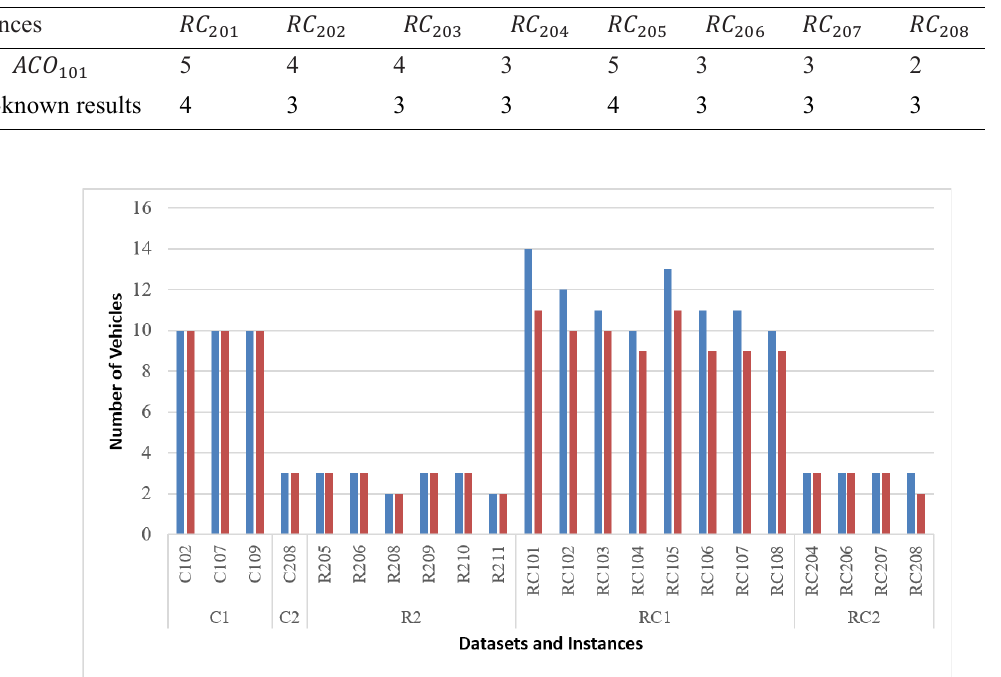
Figure 3. Performance of ACOTL over Best-known results in terms of number of